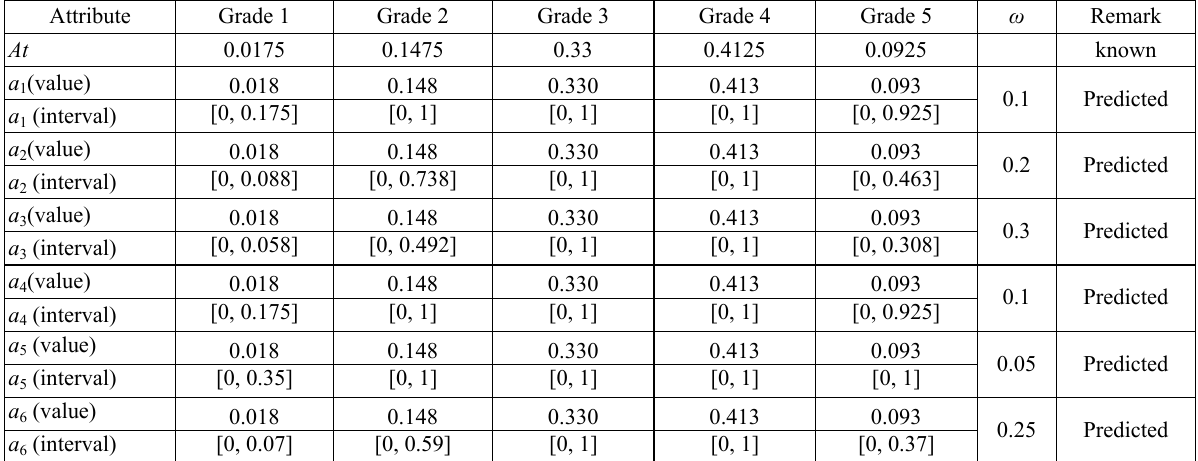
Table 5 The estimation values of missing assessments for all sub-attributes